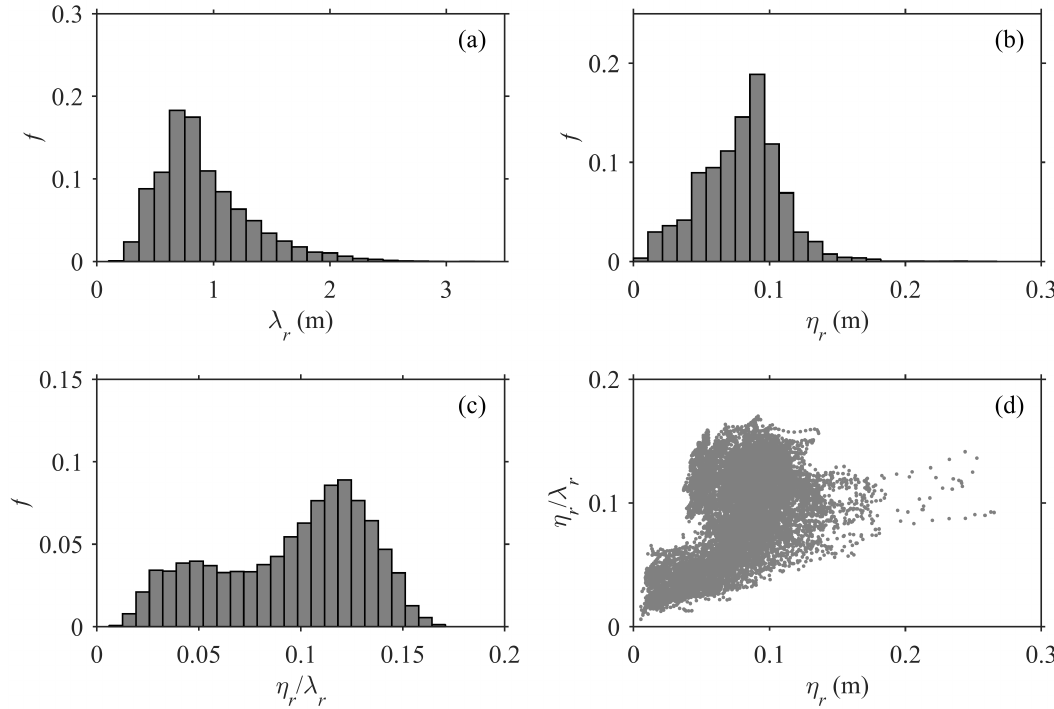
Figure 3. Probability f histograms of ( a ) ripple length λ , ( b ) ripple height η and ( c ) ripple r r = η /λ steepness ϑ . For each parameter the full range was divided into 25 bins of equal r r r width. Panel ( d ) is a scatter plot of ϑ versus η . The values shown are estimates from all r r available 0.5-m spaced, 10-m wide windows. The total number of observations amounts to